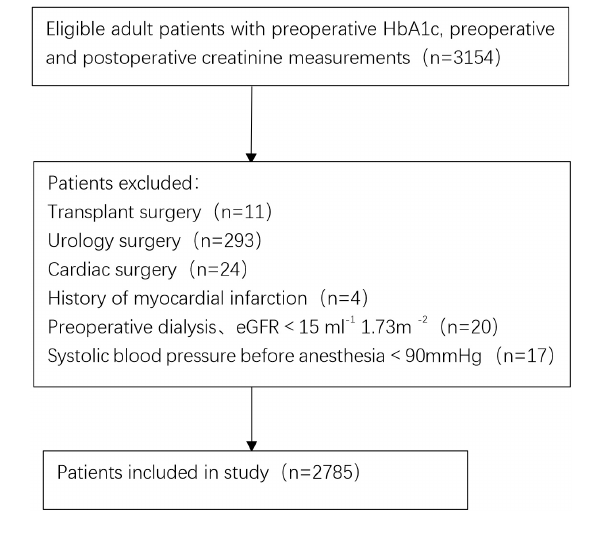
FIGURE 1 | Flow chart for patients